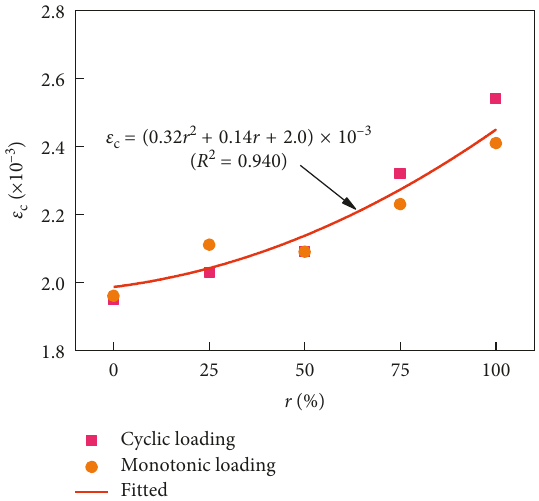
Figure 5: Effect of the RCA replacement percentage on the peak